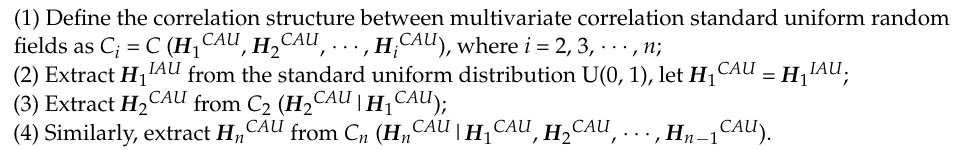
Algorithm 1 Simulation algorithm of copula-based standard uniform CCRF